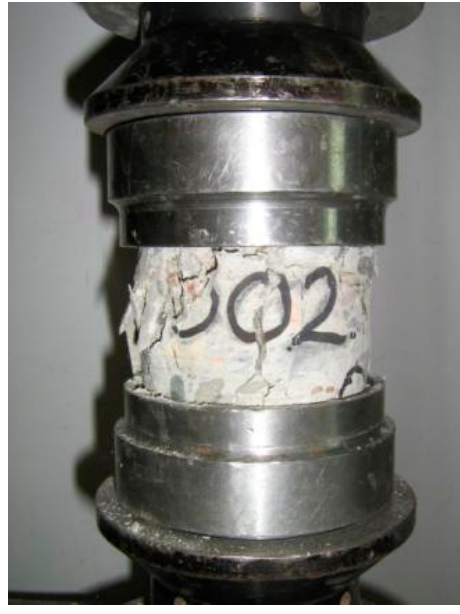
Figure 7. Sample no. 002 during the strength test.